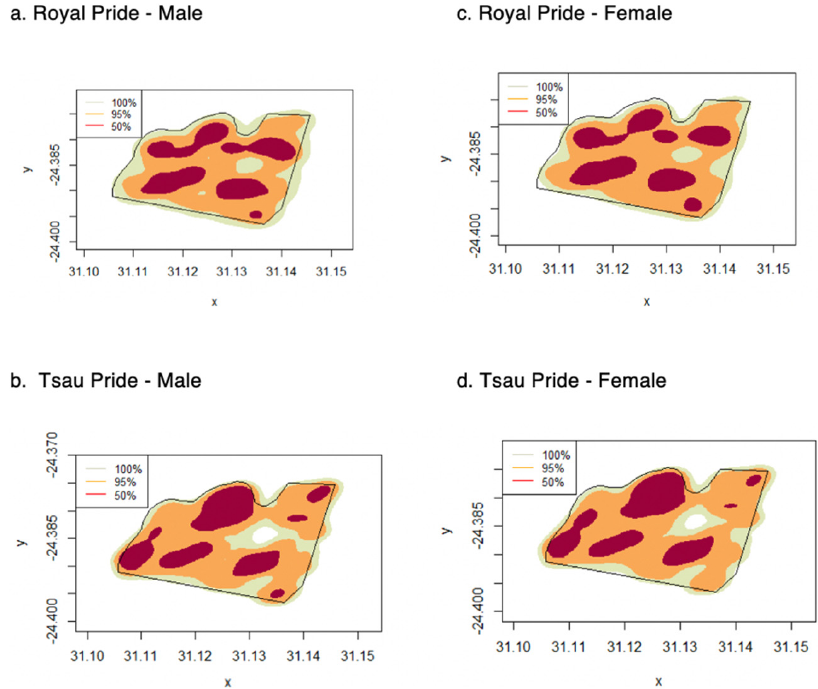
Figure 5. Home range distribution for male and female lions for the Royal and Tsau prides, using